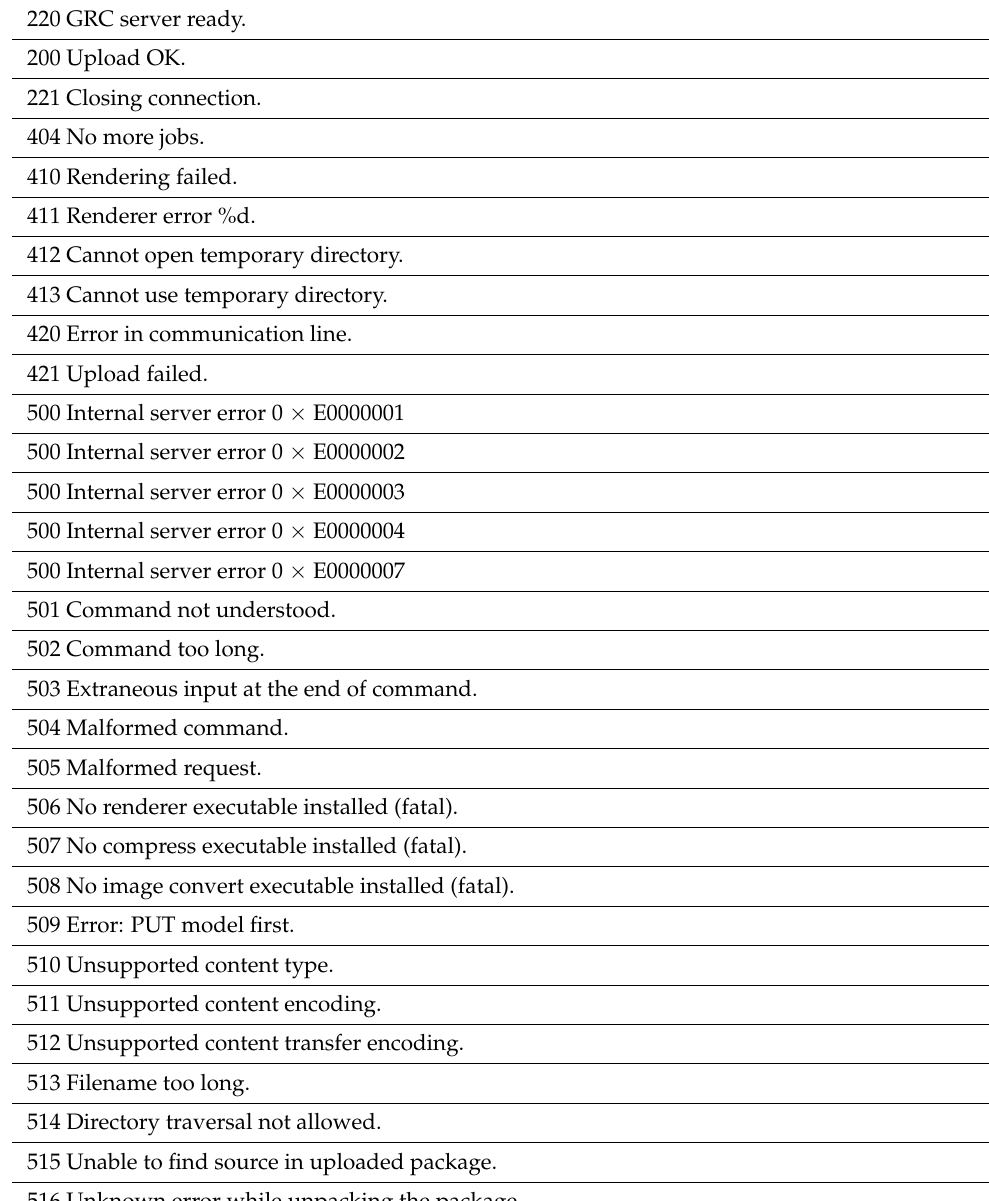
Table 2. GRC protocol reply status